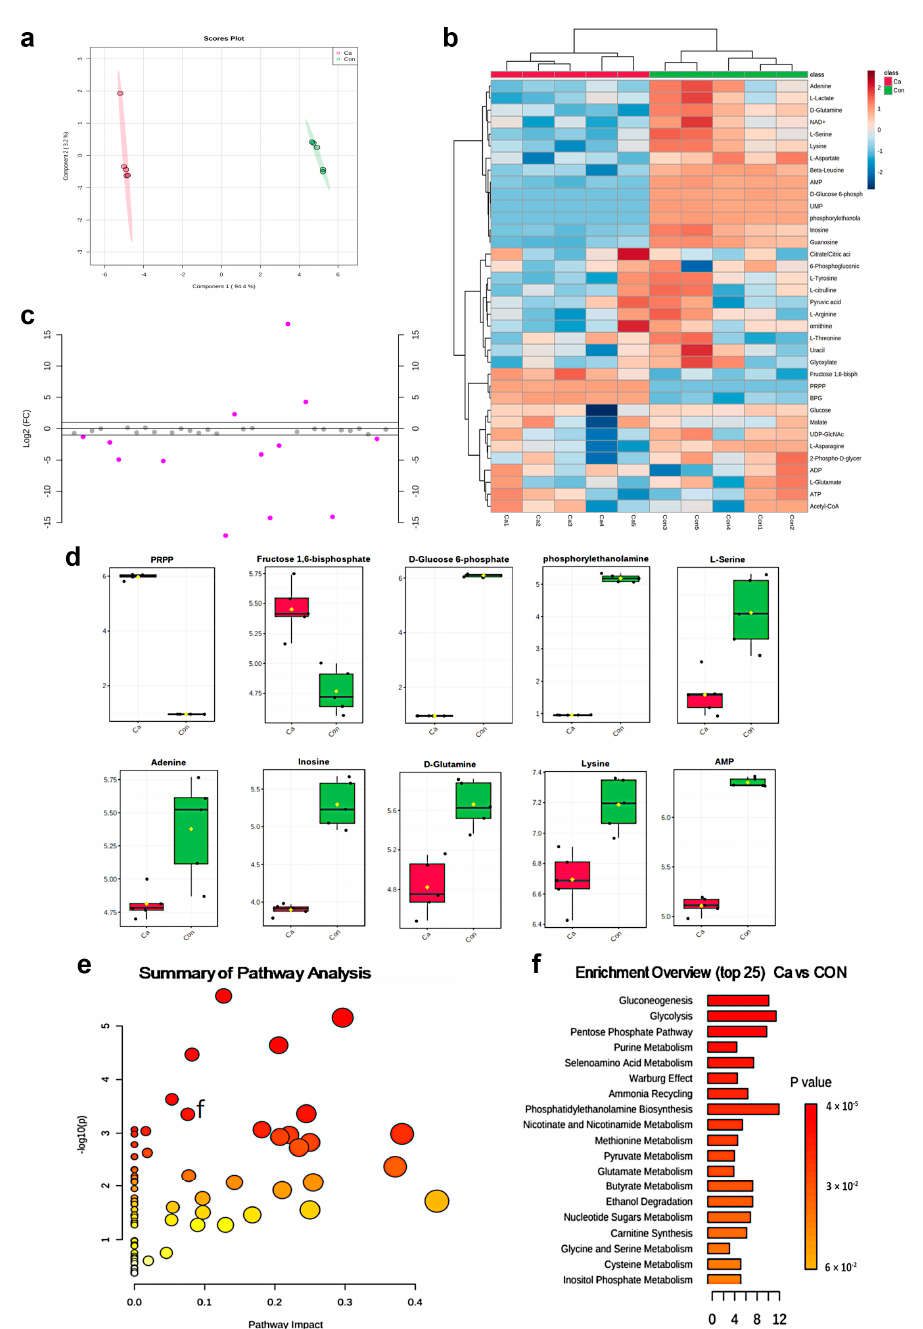
Figure 2. Metabolomics analysis of cells induced by extracellular 7.2 mM Ca 2+ . ( a ) The sparse partial least squares discriminant analysis score scatter plots based on metabolic profiles of class separation based on the top three components of Con and Ca group. ( b ) Heatmap visualization of the 36 discriminative metabolites with hierarchical clustering analysis (HCA) among the Con and Ca group. ( c ) Fold change (FC) score plot of Ca vs. Con. Purples dot represents the discriminative metabo- lites between two groups. ( d ) Boxplots of the partial eight most significant metabolites ( p < 0.05) in the analysis of variance results comparing the three groups (Con and Ca group). ( e ) Metabolic pathways are involved in simulation of extracellular 7.2 mM Ca 2+ . Scatter plot presenting enriched metabolic pathways. The color gradient indicates the significance of the pathway ranked by p -value ( y -axis; yellow: higher p -values and red: lower p -values), and circle size indicates the pathway impact score ( x -axis; the larger circle the higher impact score). ( f ) Enrichment pathway analysis of extracellular 7.2 mM Ca 2+ vs. Con